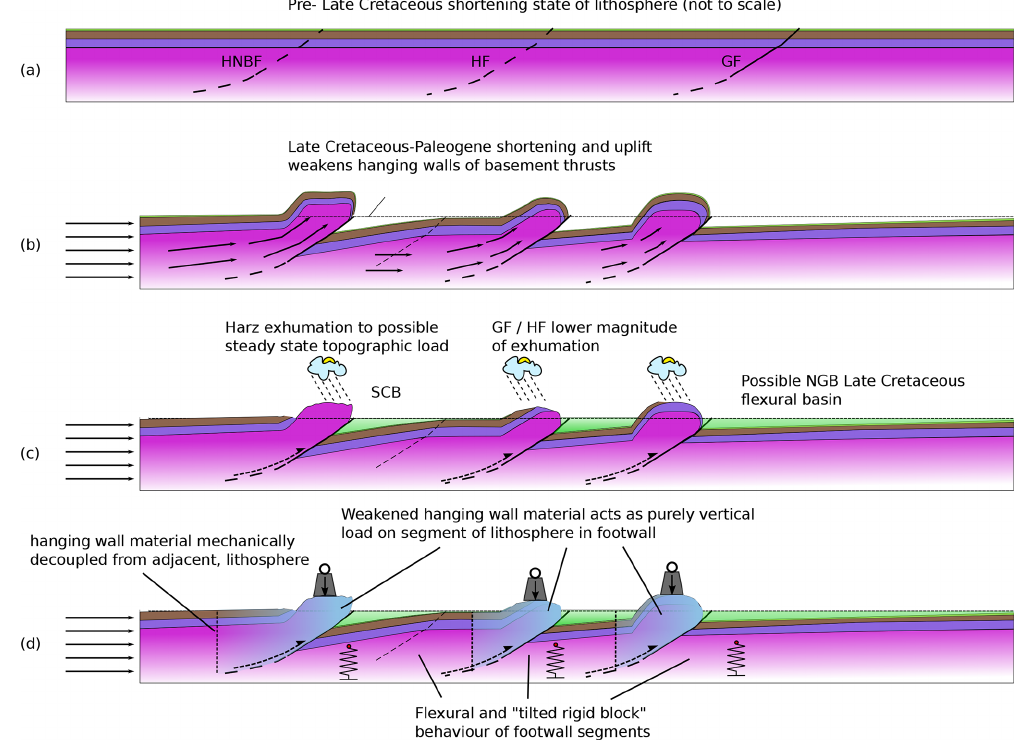
Figure 6. Cartoons of the mechanics of flexure, structural evolution, and basin evolution in the Late Cretaceous deformation system of the SCB and other basins. (a) The initial set of thrusts evolve either newly initiated or from pre-existing structures. (b) The majority of shortening occurs on the HNBF, but overthrusting also occurs on both the HF and GF. (c) Erosion of the Harz has removed all Mesozoic cover and probably led to a steady-state topography and load, balancing uplift and erosion. GF may have formed a flexural basin on the NGB since being distorted by Cenozoic subsidence. (d) Loads formed by hanging wall material are assumed to become non-cohesive due to internal deformation and elastic weakening, and they only act downwards on the footwall part of the adjacent lithospheric segment.